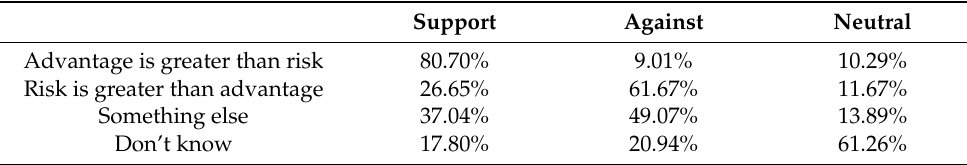
Table 2. Support for nuclear vs. risk